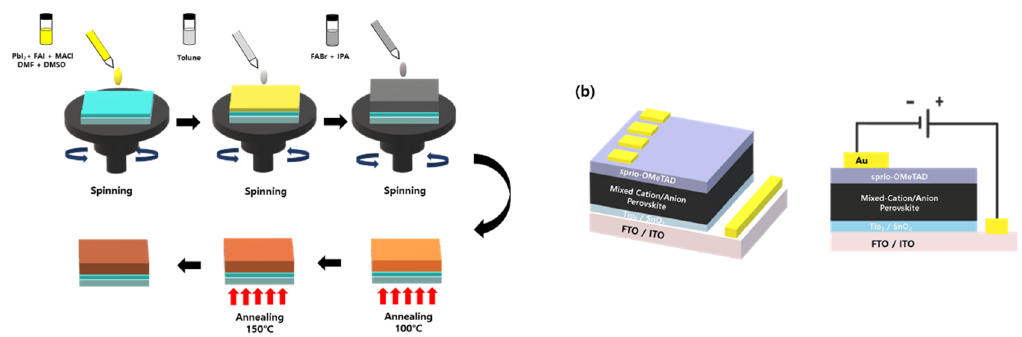
Figure 1. ( a ) Manufacturing process of mixed anionic perovskite FAPb(I/Br) 3 ; ( b ) Schematic diagram of Deep ‐ UV